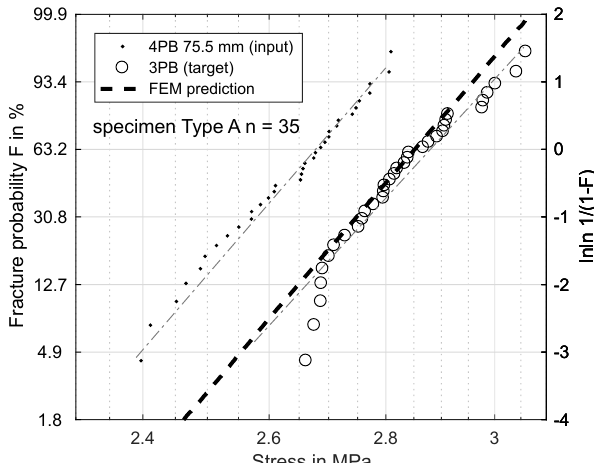
Figure 13. Specimen Type A: Prediction of fracture probability from 4PB (75.5 mm) to 3PB based on FEM analysis.